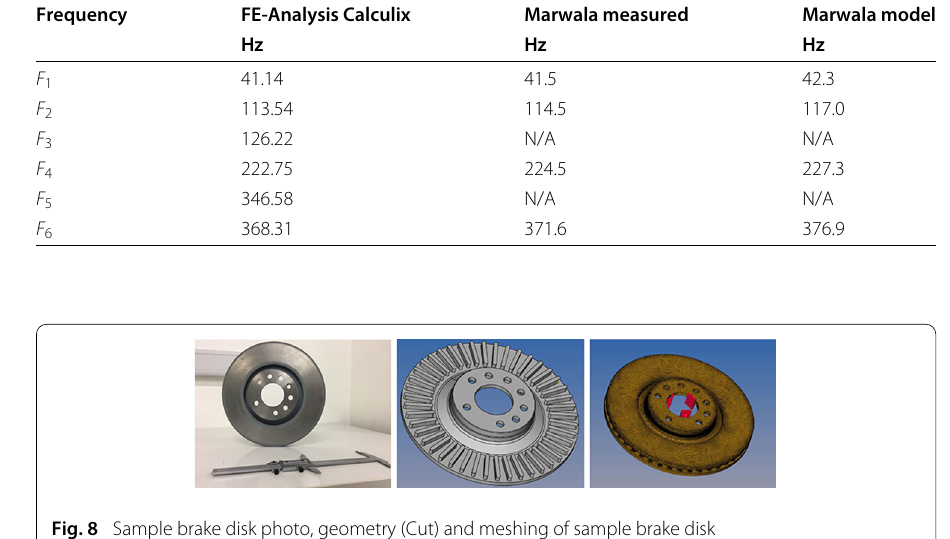
Table4 Comparison of FE-calculated natural frequencies and [1]